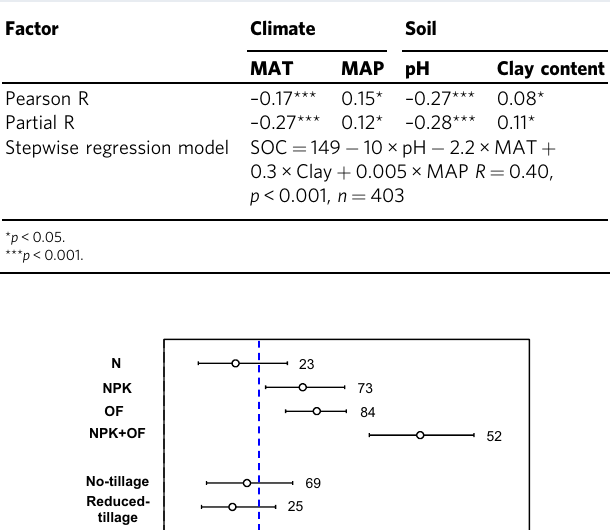
Table 3 Correlation coef fi cients (R) and stepwise regression model between SOC stocks, climatic variables (MAT, n = 612, and MAP, n = 612), and soil properties (pH, n = 519, and clay content, n = 440).